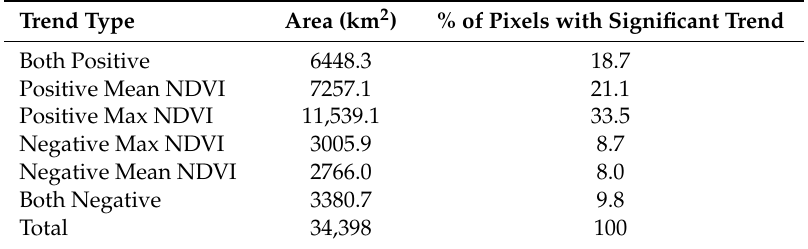
Table 2. Total area and relative proportion of vegetation change from 2000 to 2017 by trend type ( p <